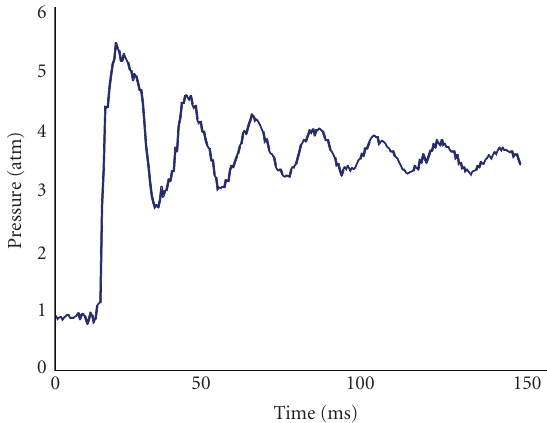
Figure 17: Pressure measurement (point #1, HTPB slab @ AOA = 7 ◦